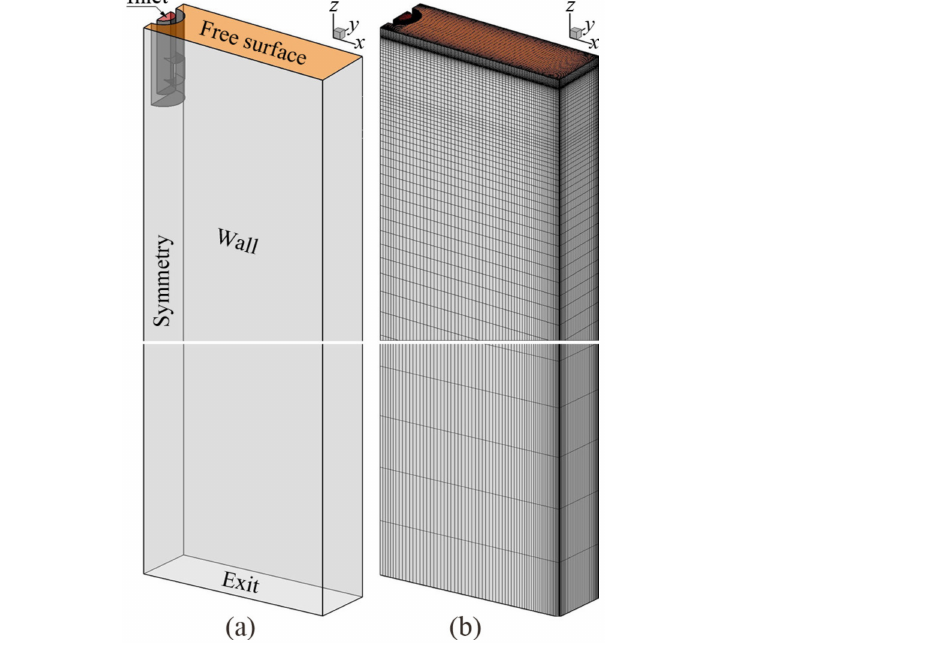
Figure 2. Schematic diagram of mold computational domain: ( a ) geometry of mold and ( b ) mesh of mold. Table 1. Parameters of continuous casting slab mold used in numerical